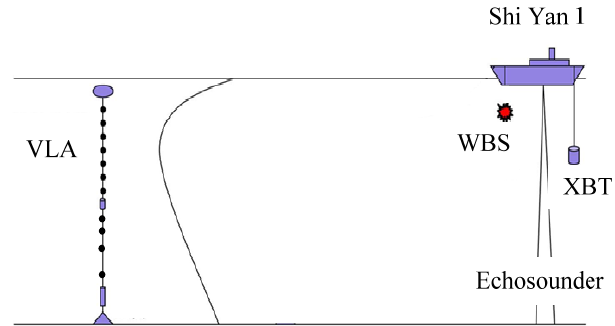
Figure 2. Experimental configuration.